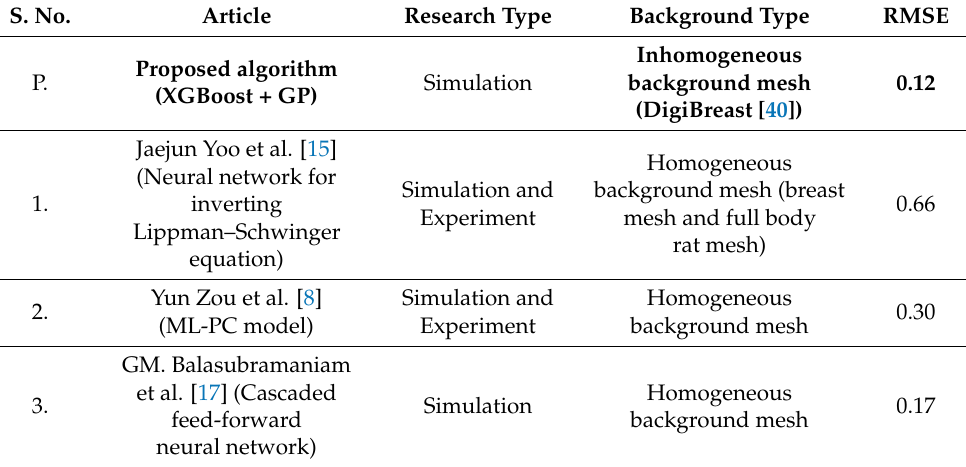
Table 3. Comparison of the XGBoost-GP algorithm with existing algorithms in terms of RMSE. S.